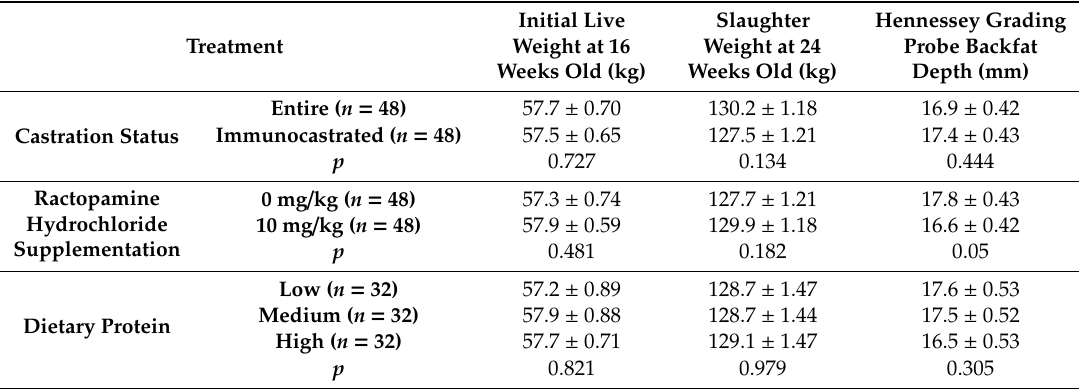
Table 3. Summary of the initial live weight, the slaughter weight and backfat depth at slaughter for 96 pig carcasses, which were selected from a larger growth study ( n = 120) investigating the e ff ects of varying dietary protein levels, with or without ractopamine hydrochloride